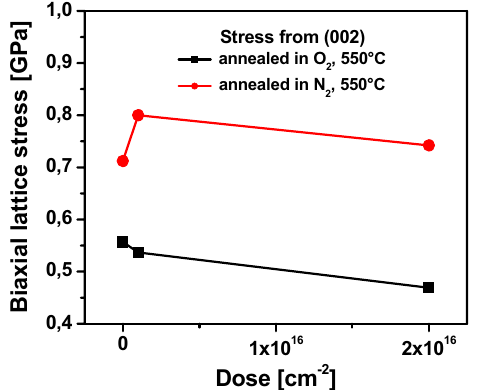
Fig. 3. A biaxial lattice stress from a (002) diffraction line as a function of the dose for N-implanted ZnO:Ga films, annealed in O 2 at 550 ◦ C for 30 min, and annealed in N 2 at 550 ◦ C for 10 s.